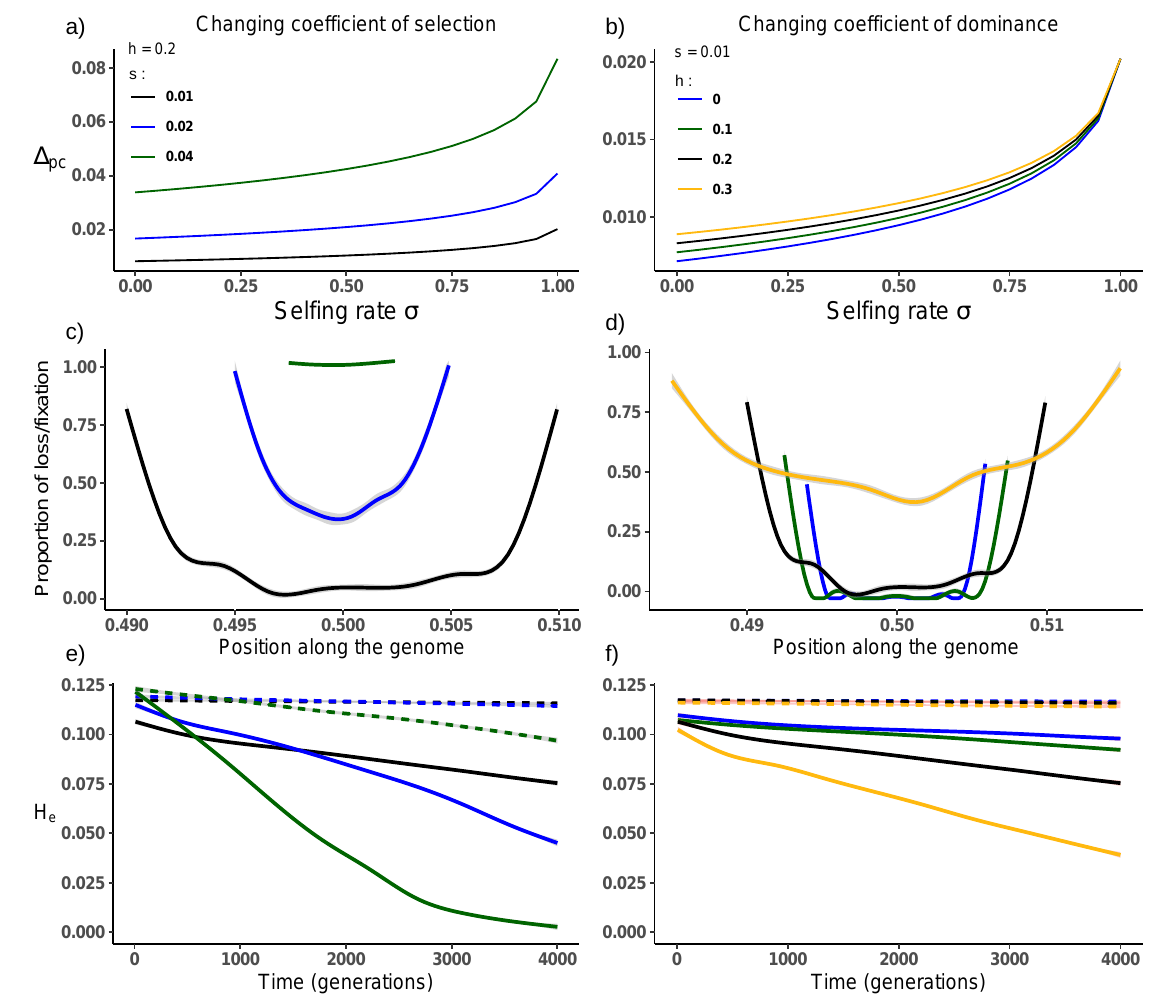
Figure 2 – Effects of levels of selection and dominance on selection dynamics within a POD zone. Left panels show the effects of varying the coefficient of selection at a load locus s ( s = 0.01, 0.02 and 0.04 , corresponding to n L = 100, 50 and 25 loci). Dominance is fixed at h = 0.2 and s H = 0.45 . Right panels show the effects of varying dominance ( h = 0, 0.1, 0.2 and 0.5 with n L = 60, 75, 100 and 150 ) with selection fixed at s = 0.01 . Panels a) and b) show theoretical rates of increase in frequency for a recombinant hap- lotype that loses a mutation from one end. Panels c) and d) show observed frequencies of fixation/loss along the POD zone at generation 4000 (x values represent the position 4 M of the loci along the chromosome). The selfing rate σ = 0.95 and linkage ℓ = 10 − . Panels e) and f) show losses in heterozygosity ( H e ) over time in populations with a high 4 M selfing rate ( σ = 0.95 ) and either loose linkage ( ℓ = 10 − , solid lines) or tight linkage 5 M ( ℓ = 10 − , dashed lines). Population size N = 1000